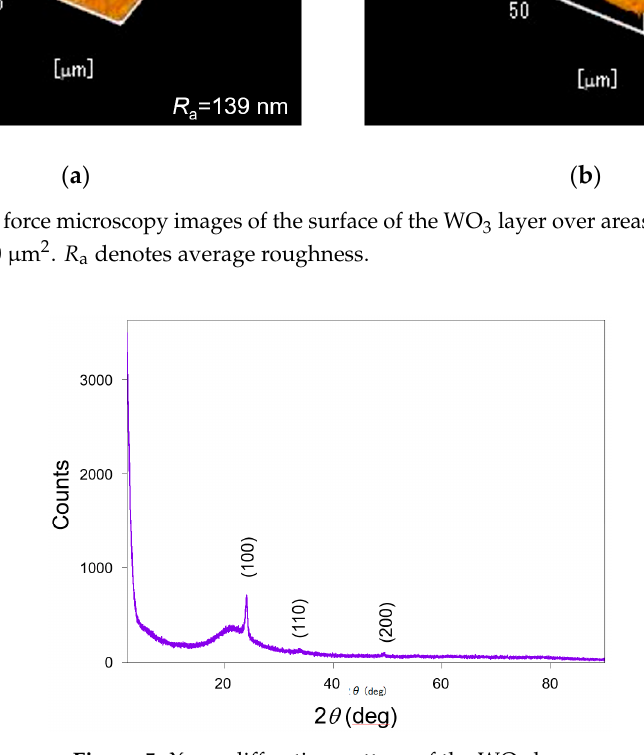
ff raction pattern of the WO Figure 5. X-ray diffraction pattern of the WO 3 layer. Figure 5. X-ray di Figure 5. X-ray diffraction pattern of the WO 3 layer. 3 Figure 5. X-ray diffraction pattern of the WO 3 layer.